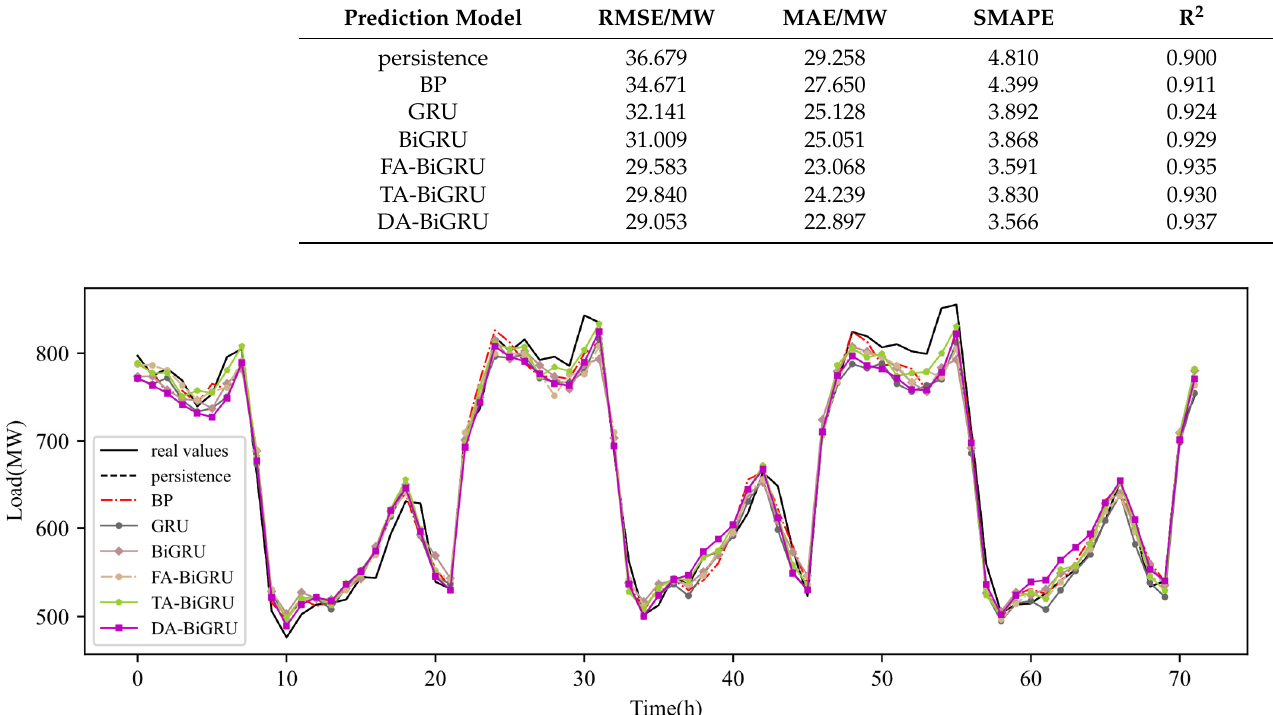
Figure 7. Case study 1: comparison of forecasting results on 29–31 December 2018.